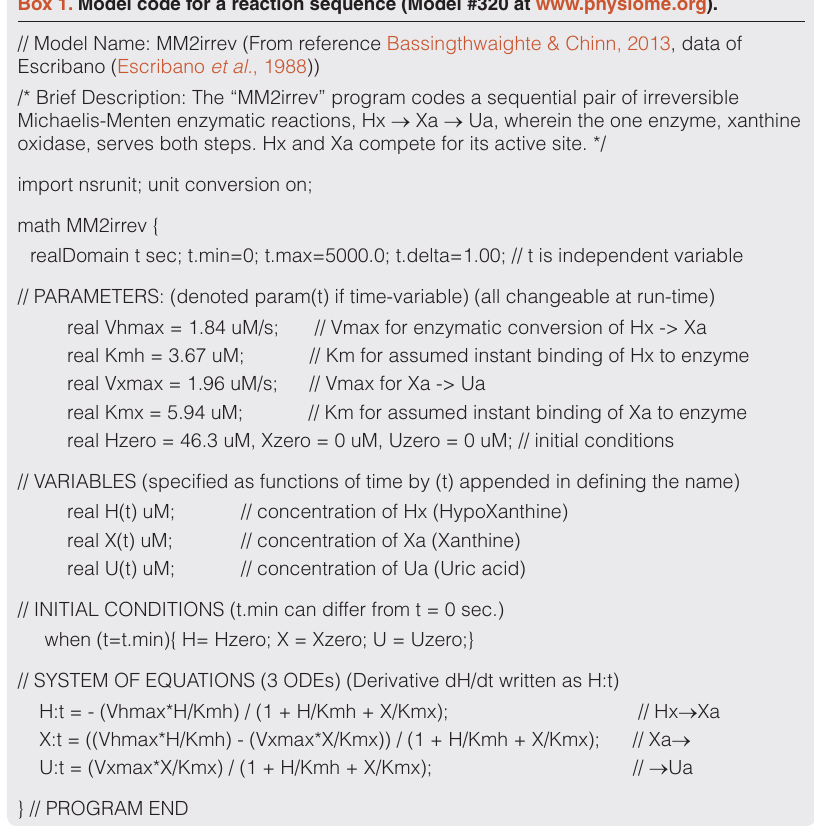
parameter values on them. The system is diagrammed in Figure 1 and the code is provided in Box 2.